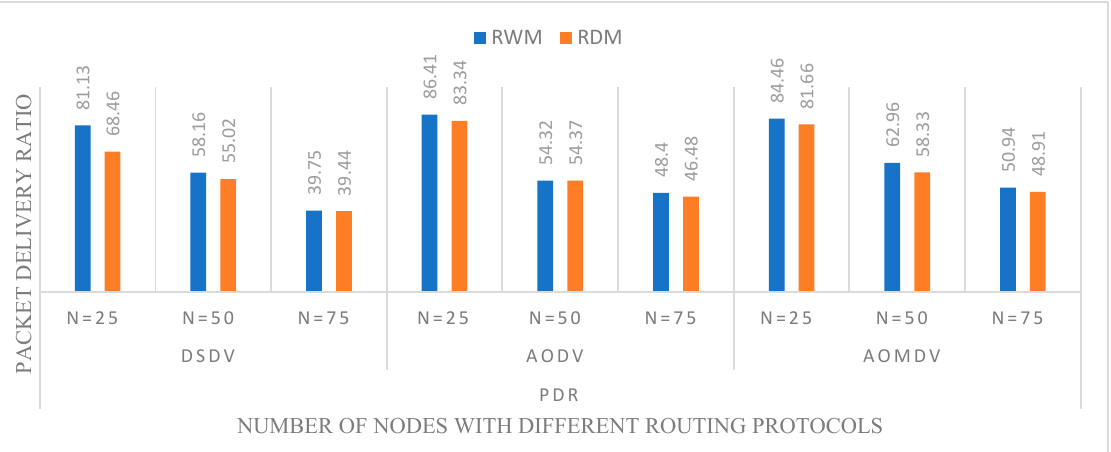
Figure 4. Performance analysis of RWM and RDM on various routing protocols in terms of PDR .